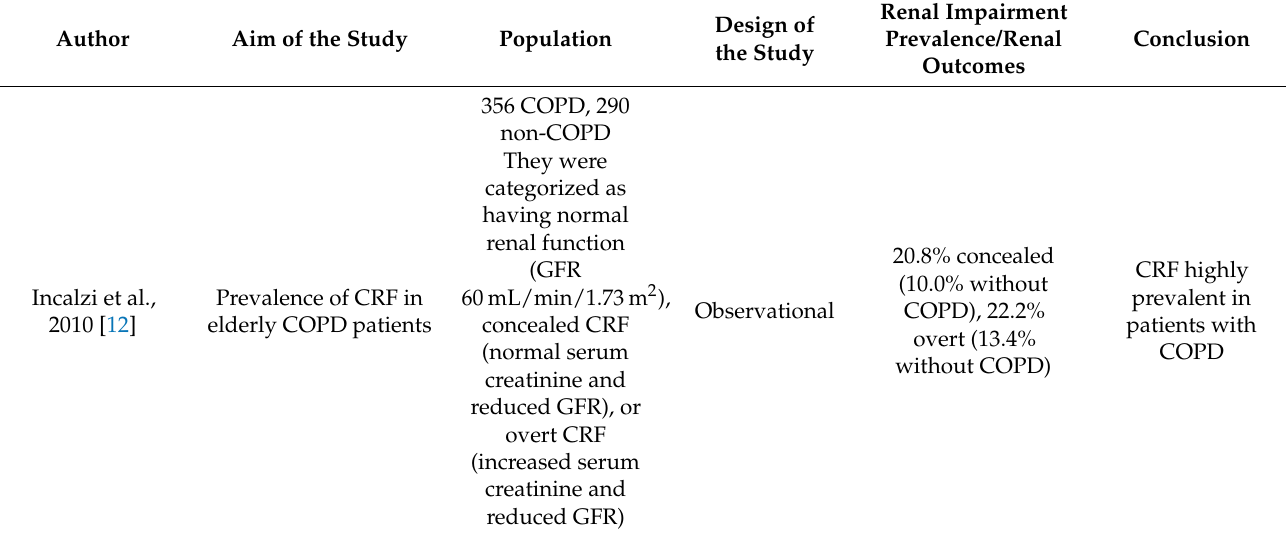
Table 2. Summary of main characteristics and findings of the studies evaluating the prevalence of renal impairment in COPD